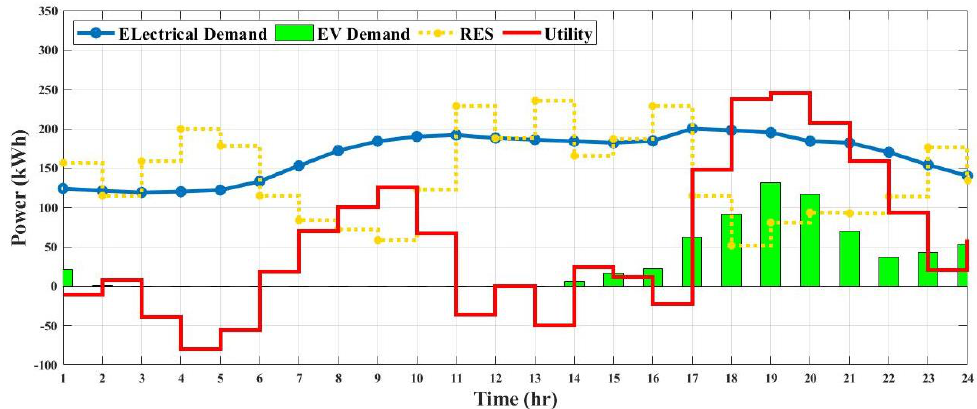
Figure 11. Addition of renewable energy resources